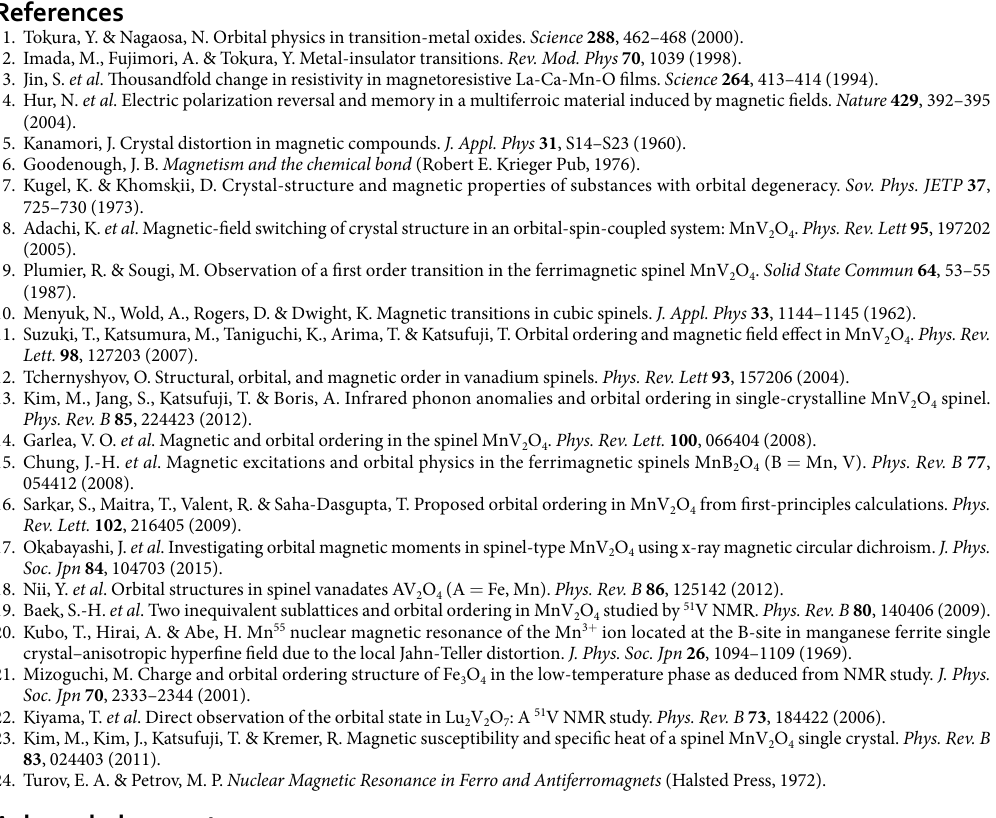
the orbital plane where the xy state locates. This interpretation is applicable to all the states. Therefore, the − x y 2 2 and the xy states are indistinguishable in the sense that − x y 2 2 is merely a 45° rotated state of xy around the z axis. However, in the limited set of 3 d states, such as z 2 and − x y 2 2 in e g or xy , yz and zx in t 2 g , the orbital states can be distinguished from each other by the angular variation of the NMR frequency.